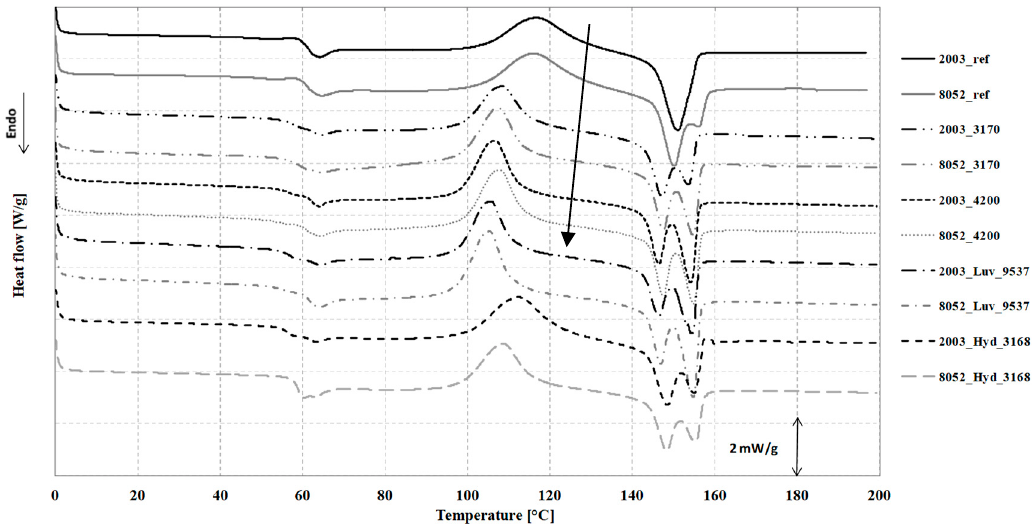
Figure 11. The DSC curves of reference PLA and foamed samples (1st heat-up, 5 °C/min). Table 8. DSC results of foamed samples and unfoamed, extruded PLA (1st heat-up, 5 °C/min). Type of Sample T